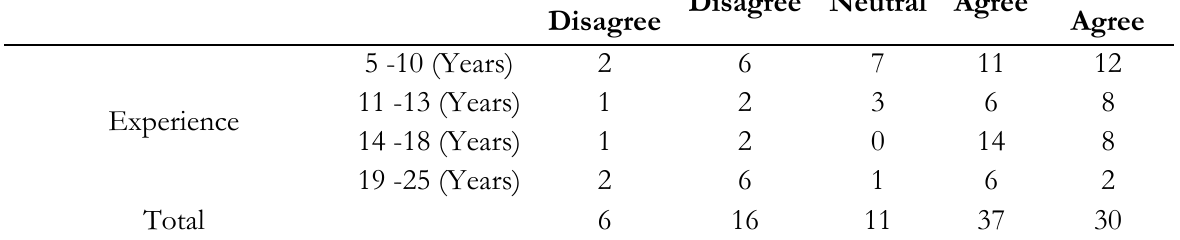
Table 4: EXP * Q4 Cross